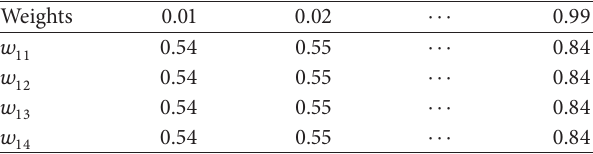
Table 4: The 99-table of weights for indices 𝐶 11 , 𝐶 12 ,𝐶 13 ,𝐶 14